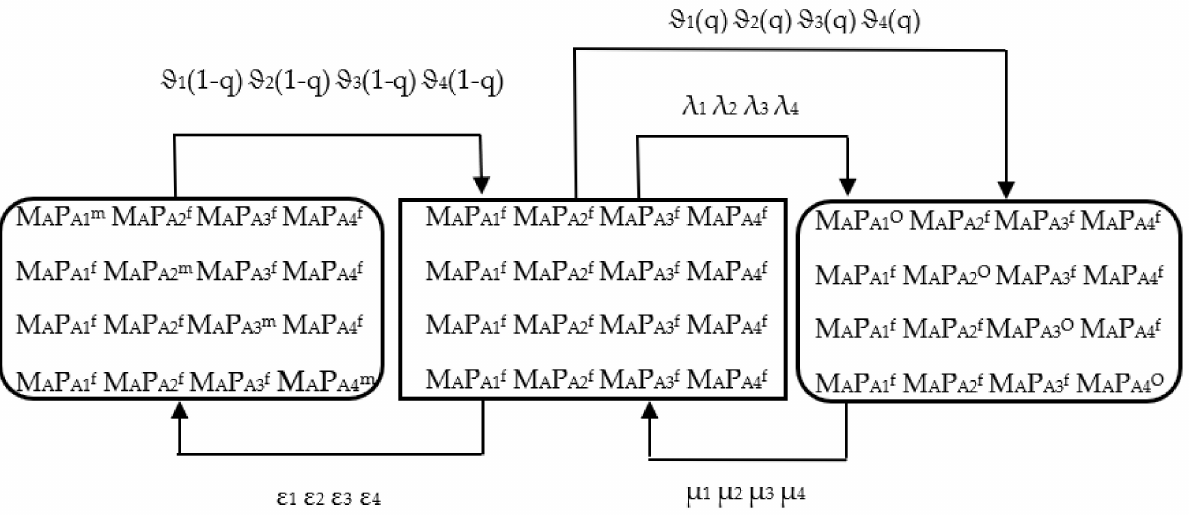
Figure 5. Transition diagram for Module A